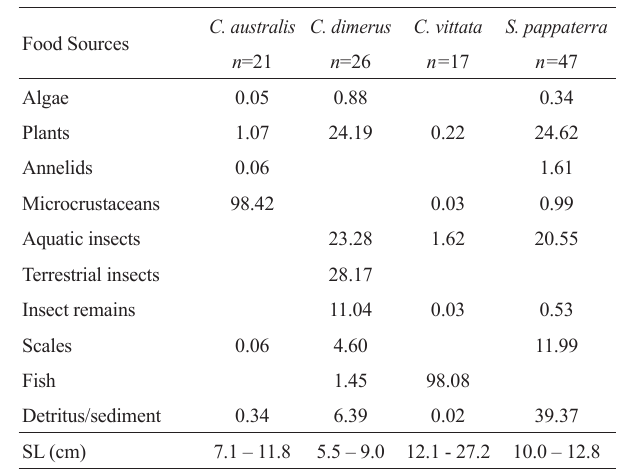
Table 1. Percentages (IAi) of food resources consumed by four species of cichlids from the Cuiabá River basin, Mato Grosso, Brazil. n = number of stomachs. SL = standard length. C. australis = Chaetobranchopsis australis; C. dimerus = Cichlasoma dimerus; C. vittata = Crenicichla vittata; S. pappaterra = Satanoperca pappaterra.